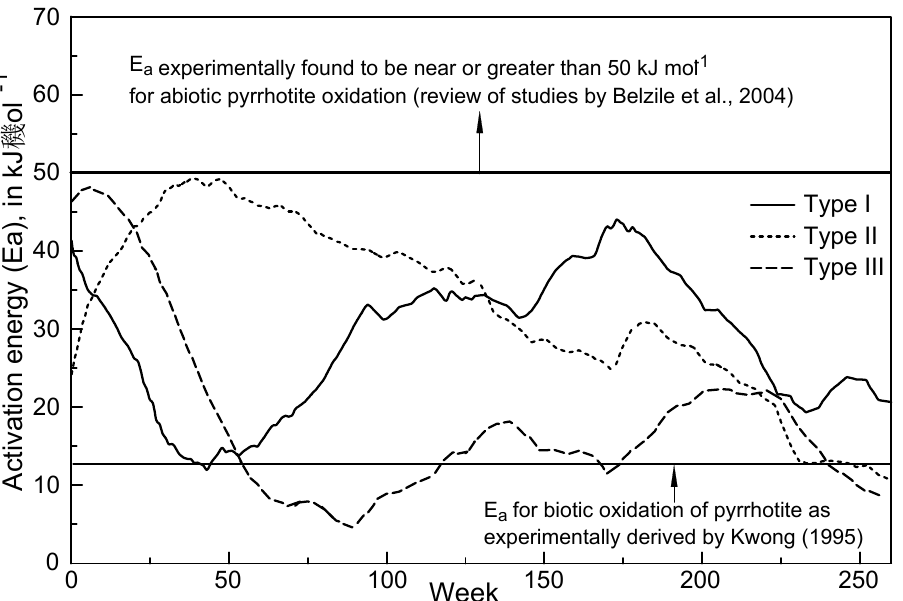
Figure 7. Activation energy of sulfide oxidation in Diavik waste rock calculated from the concentration in leachate from the warm and cold humidity SO 4